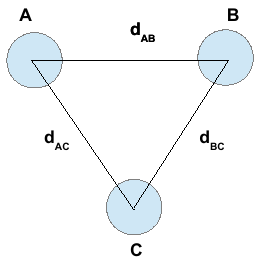
Figure 8. Estimated distances for the